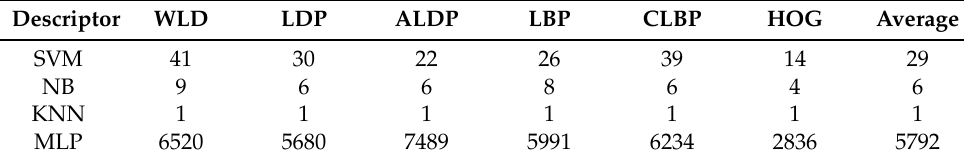
Table 7. Training times of various classifiers (times are given in